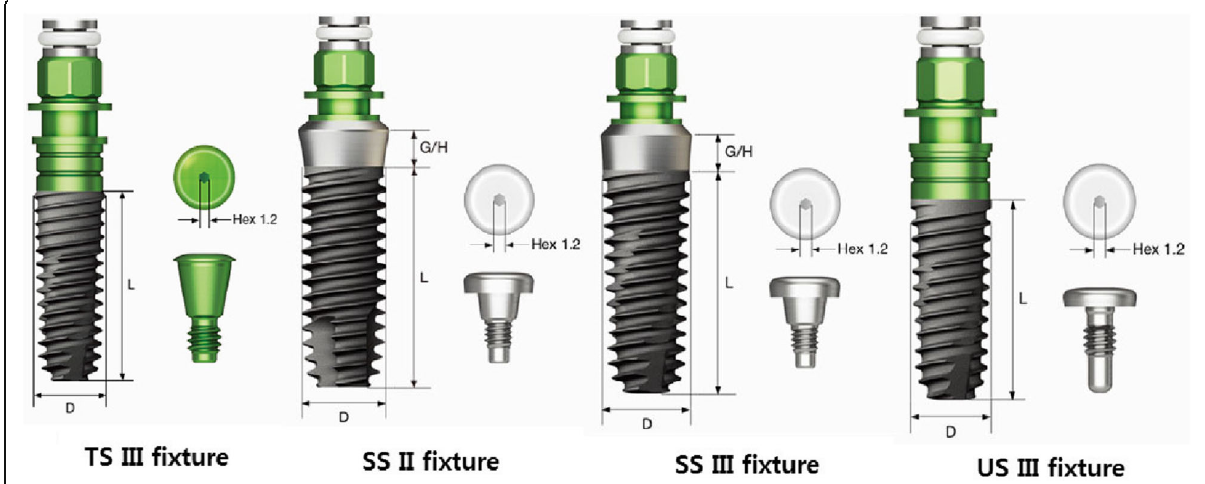
Fig. 1 Osstem implant TS III, SS II, SS III, and Us III